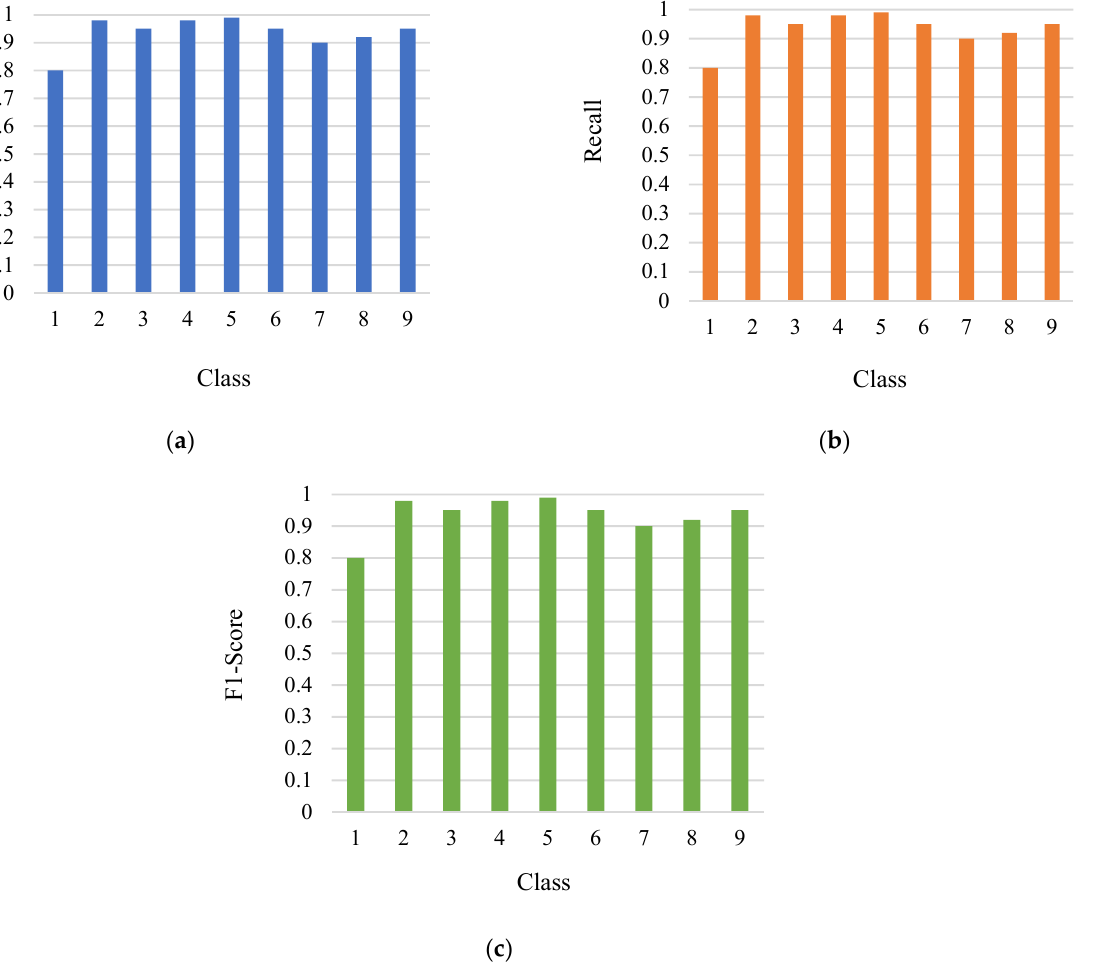
Figure 10. ( a ) Precision; ( b ) Recall; ( c ) F1-Score.